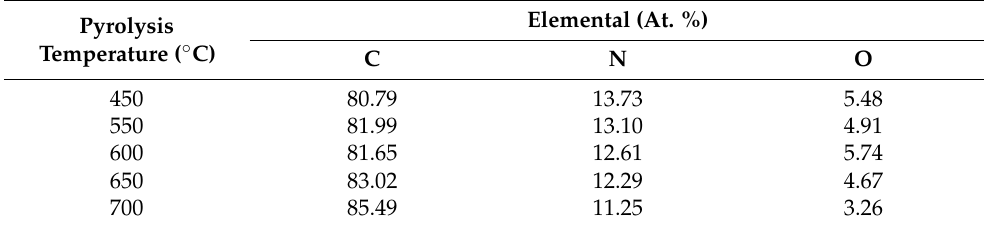
Table 2. XPS elemental analysis of CMS pyrolyzed at a variety of temperature.